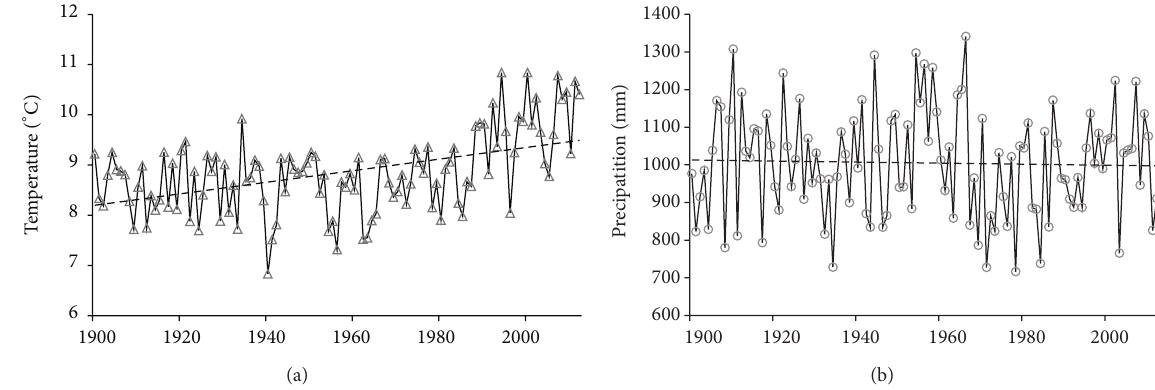
Figure 2: (a) Annual temperature in Central Europe, 1900–2010. (b) Annual precipitation in Central Europe, 1900–2010.